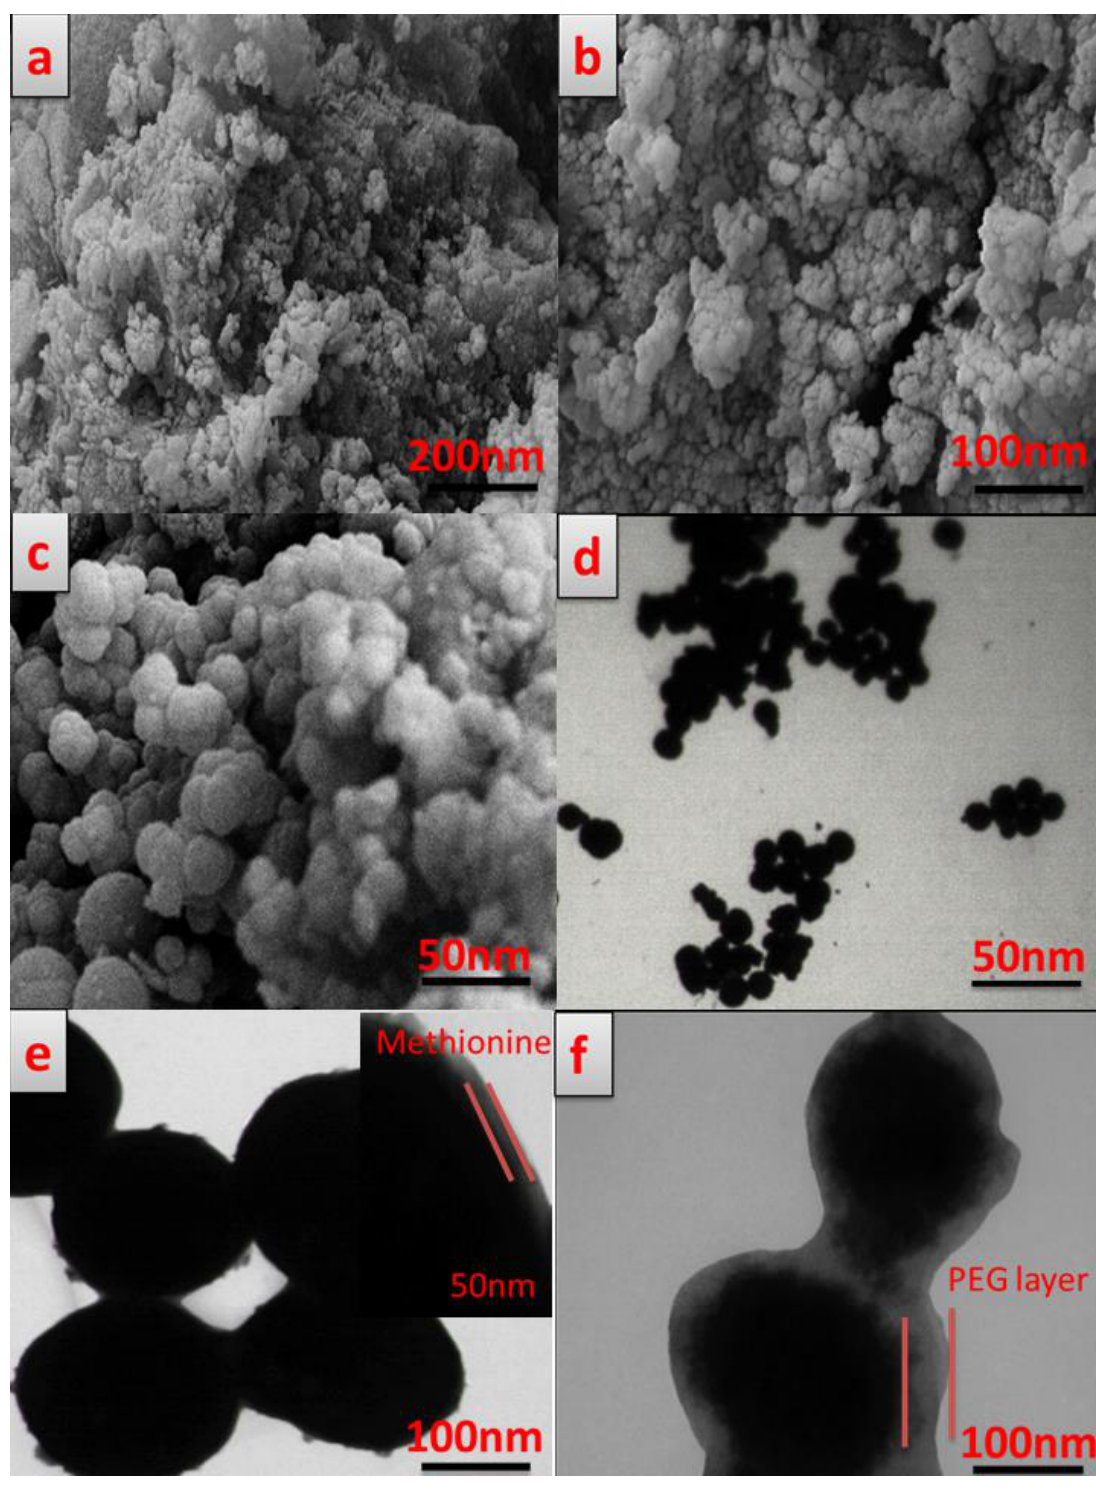
Figure 4. FESEM micrographs of Ni 1−x Co x Fe 2 O 4 NP ( a ), Ni 1−x Co x Fe 2 O 4 @Methionine NP ( b ), and Ni 1−x Co x Fe 2 O 4 @Methionine@PEG NP ( c ), and TEM images of Ni 1−x Co x Fe 2 O 4 NP ( d ), Ni 1−x Co x Fe 2 O 4 @Methionine NP ( e ), and Ni 1−x Co x Fe 2 O 4 @Methionine@PEG NP ( f ).